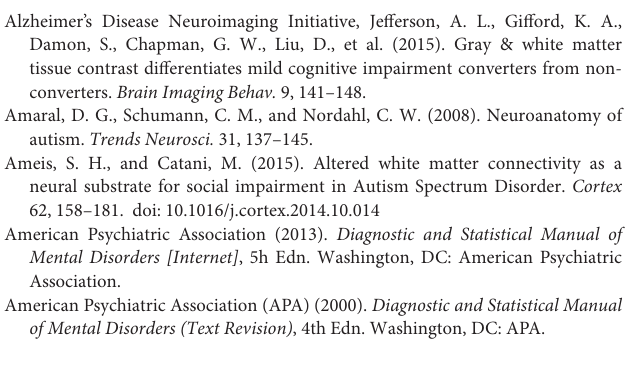
Supplementary Figure 1 | Graphic representation of individual ADOS CSS at 18 and 24 months of age in our sample ( n = 20 HR participants). Color code represents individual diagnosis outcome at age 3. HR-TD: high risk for ASD with typical development; HR-non-TD: high risk for ASD with atypical development;